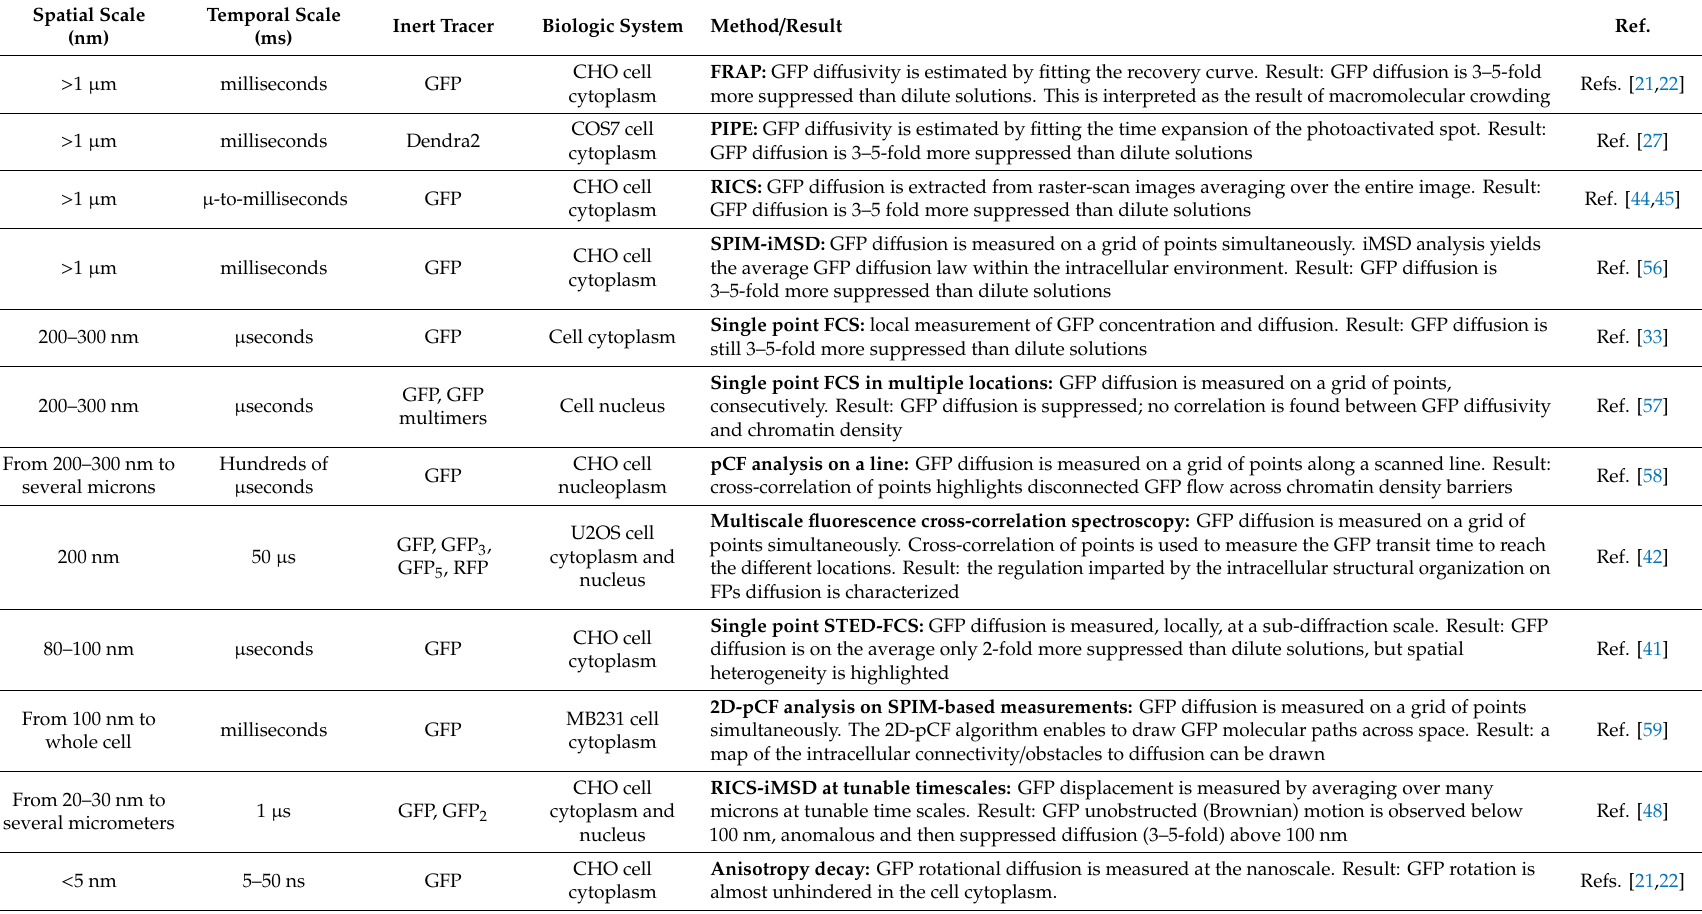
Table 2. Summary of the most relevant contributions on the use of genetically encoded FPs as inert tracers of the intracellular environment. The spatial and temporal scale of reference is reported for each selected study, as well as the peculiar FP used, the biologic system chosen and a brief summary of the methodological approach employed, and results